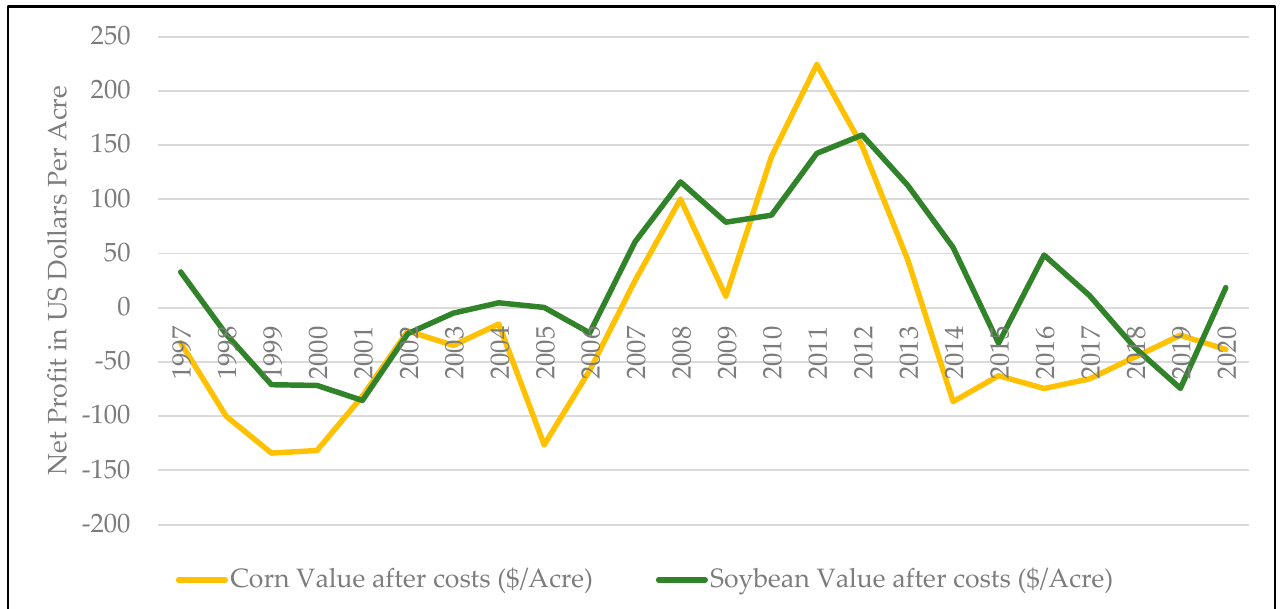
Figure 12. LandTrendr temporal signature for a field that was identified as change from grass to crop between 2008 and 2020 but showed signs of cropland in earlier years.